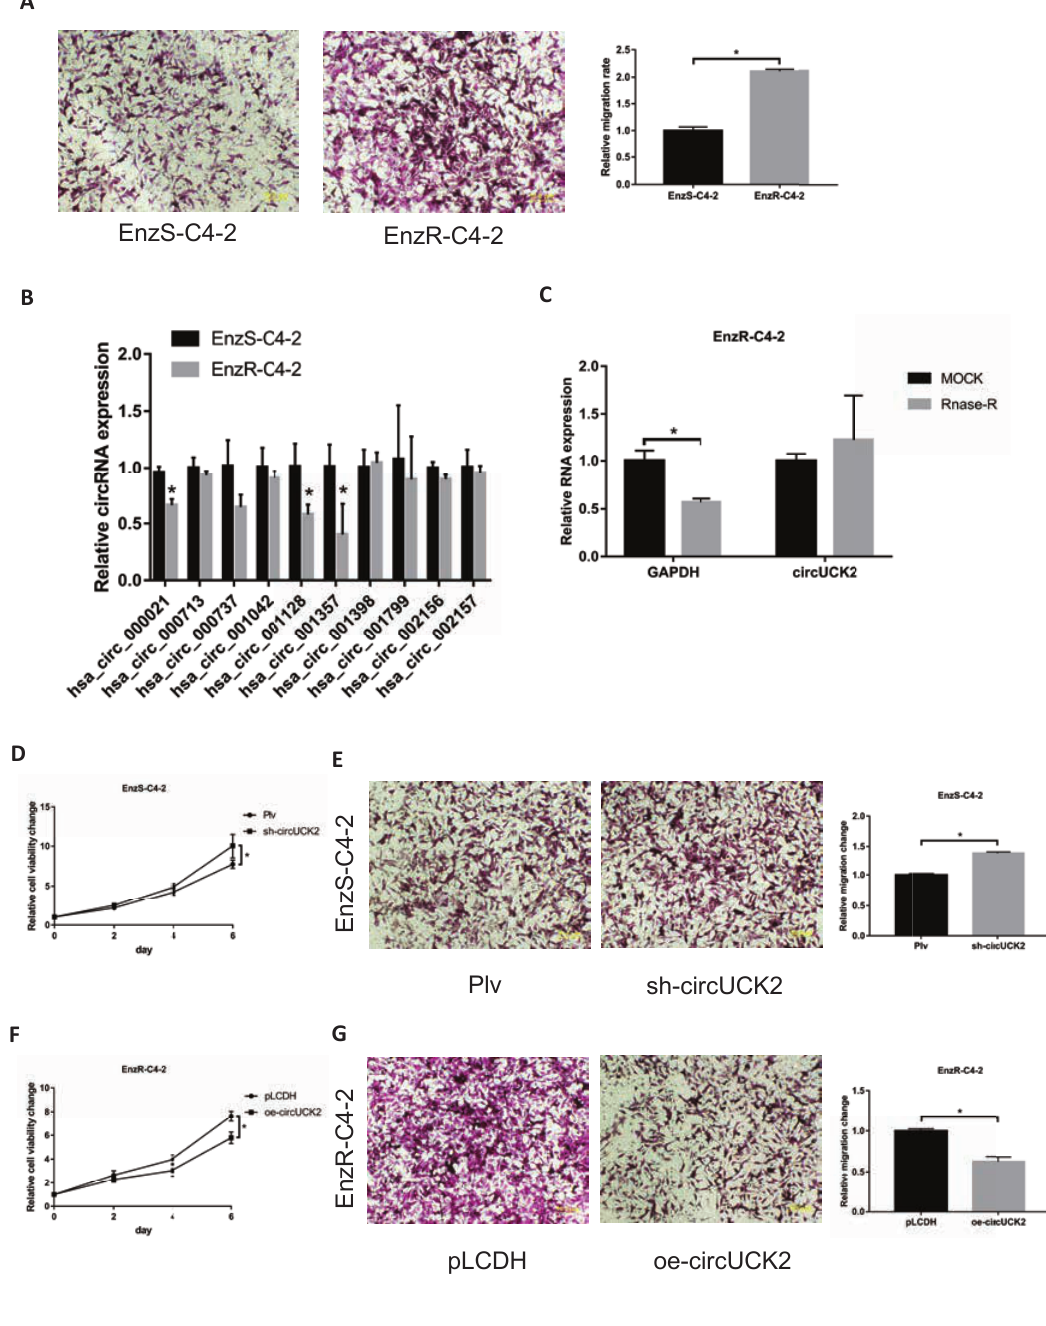
Fig.1 CircUCK2 decrease EnzR cell proliferation and